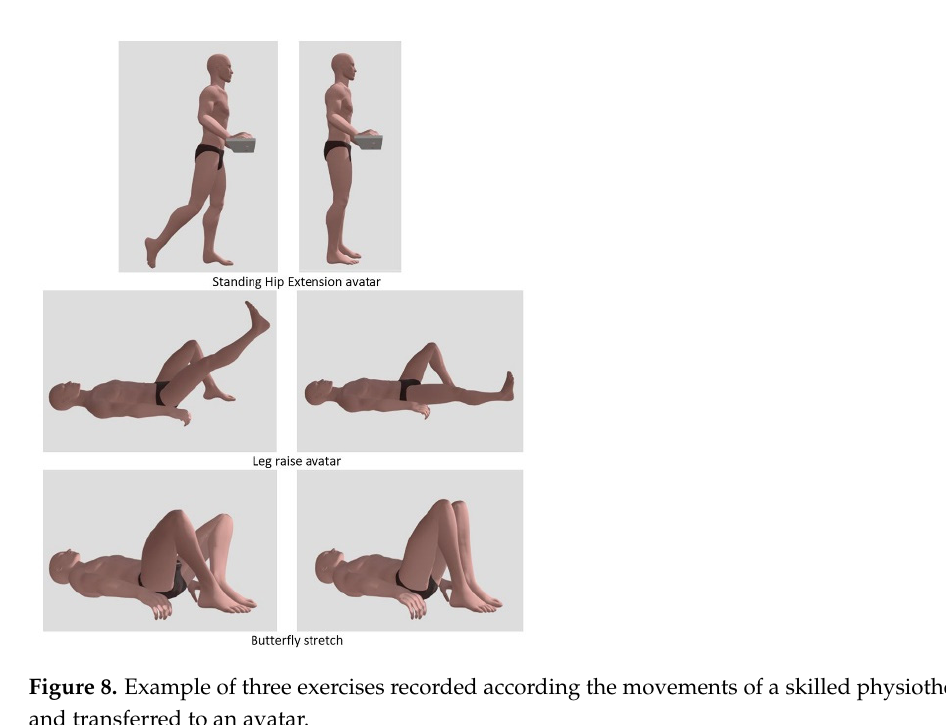
Figure 7. Physiotherapist wearing the motion capture device.